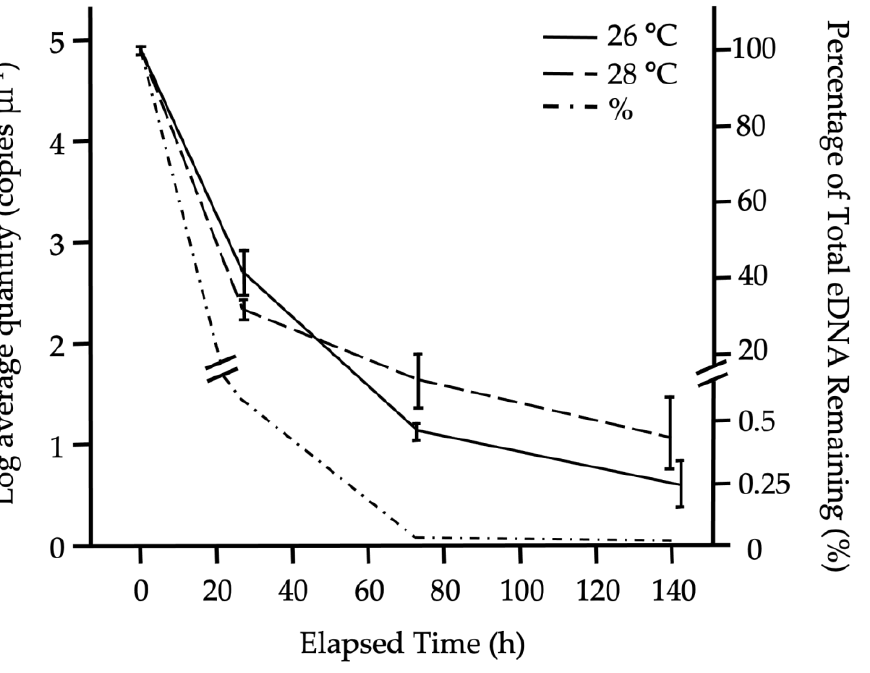
Figure 5. Decay of Chironex fleckeri eDNA under two temperature treatments (26 °C and 28 °C), displaying log average quantity (copies μL −1 ) over a 140 h period, and percentage (%) of total eDNA